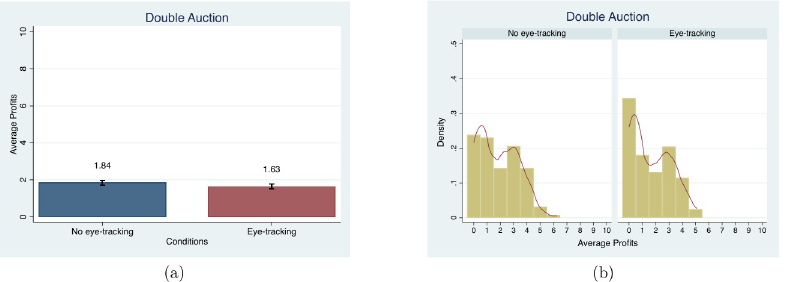
Fig 5. Mean and distribution comparisons in the average profits of 10 periods. Note. Red lines in (b) present the univariate kernel density estimation.